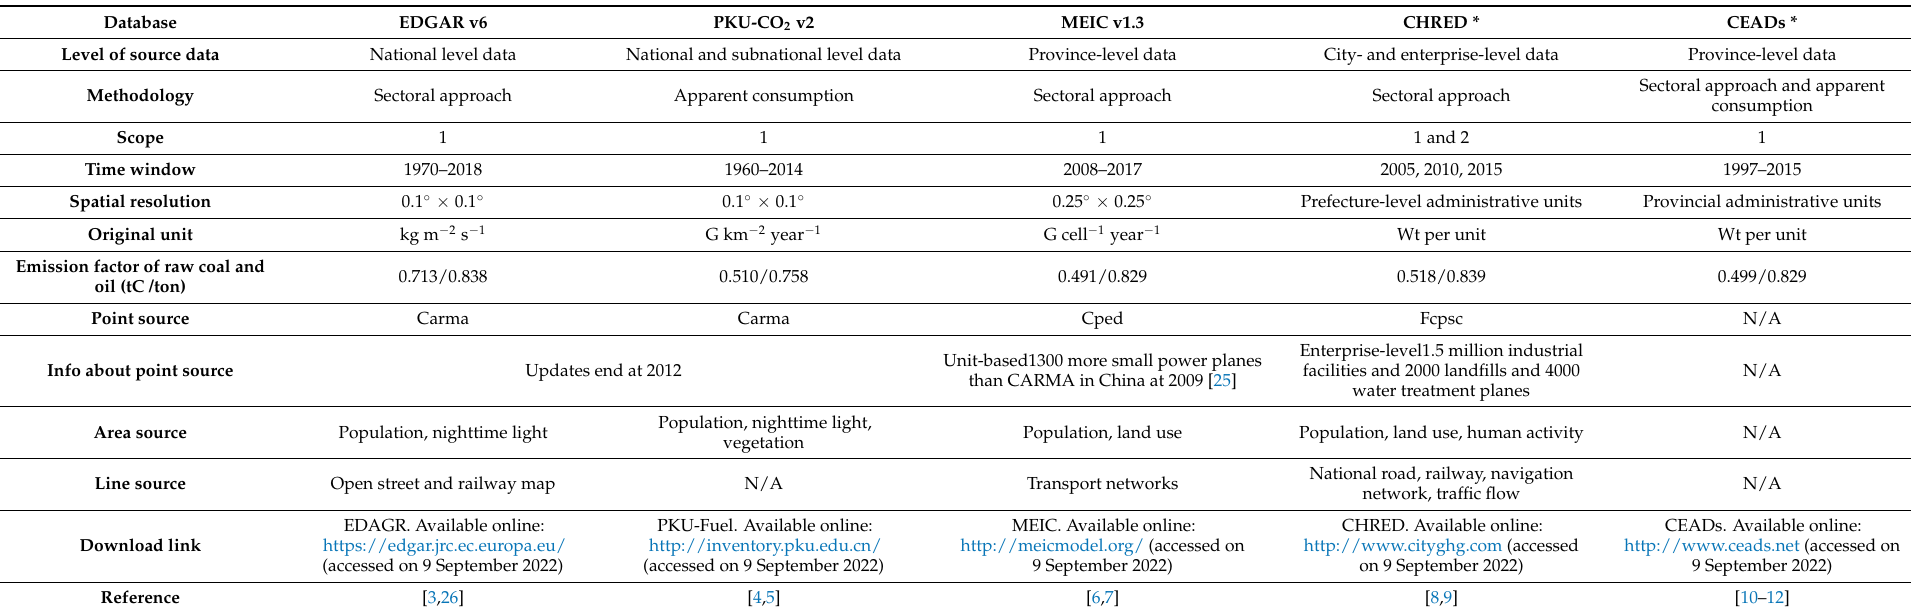
Table 1. Information about the emission inventories used in this